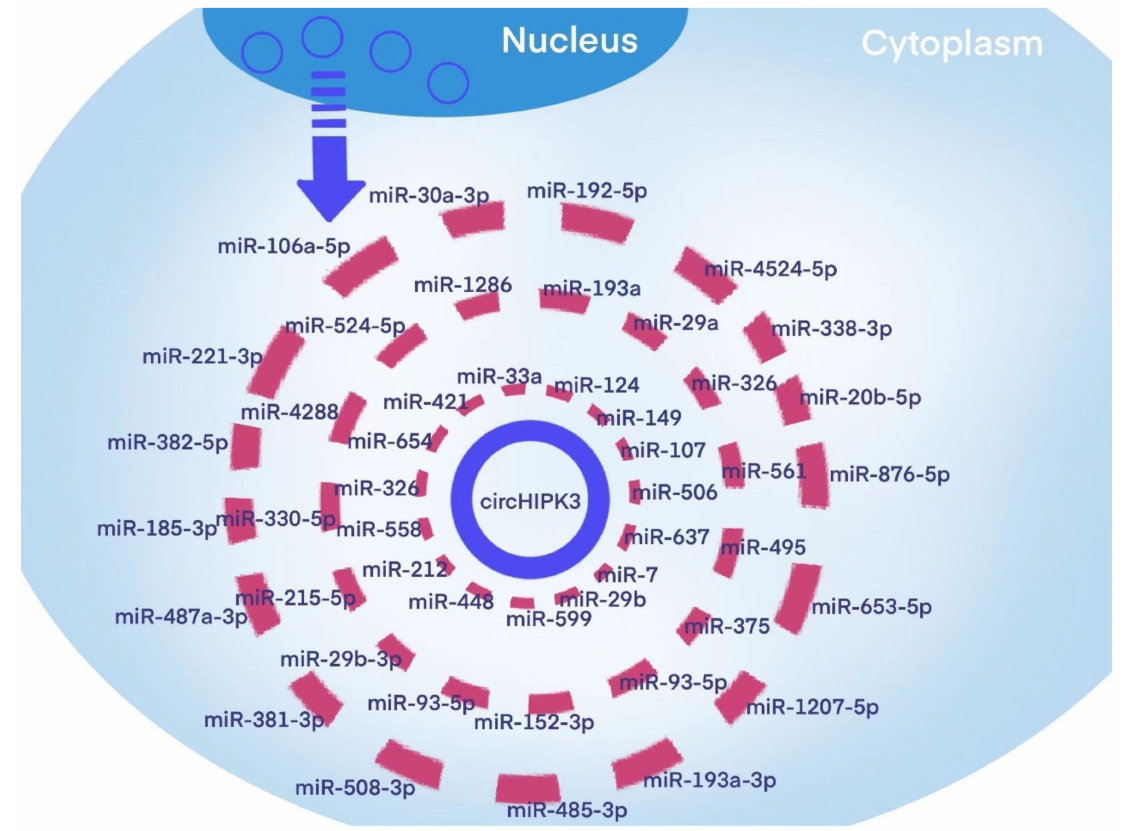
Figure 2. CircHIPK3 and the miRNAs that it